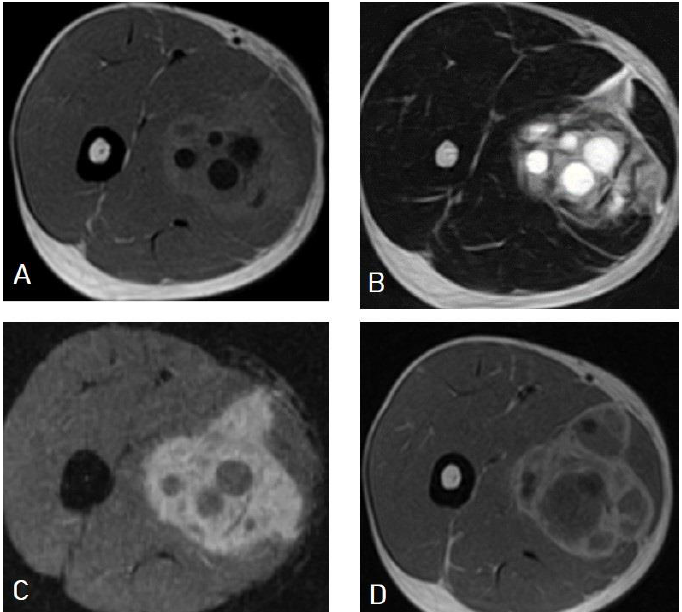
Figure 24. Selected images of thigh MRI of a 23-year-old male showing about an 11 × 8 × 8 cm heterogeneous complex cystic lesion within the anteromedial intramuscular compartment of the upper right thigh with thickened edematous adjacent subcutaneous fat containing multiple small daughter cysts appearing hypointense on T1-weighted images ( A ), hyperintense on T2-weighted images ( B ), hyperintense on fat-suppression sequences ( C ), and marginal wall enhancement on T1 with contrast ( D ), which is typical appearance of intramuscular hydatid cyst with superimposed infection and impending rapture.